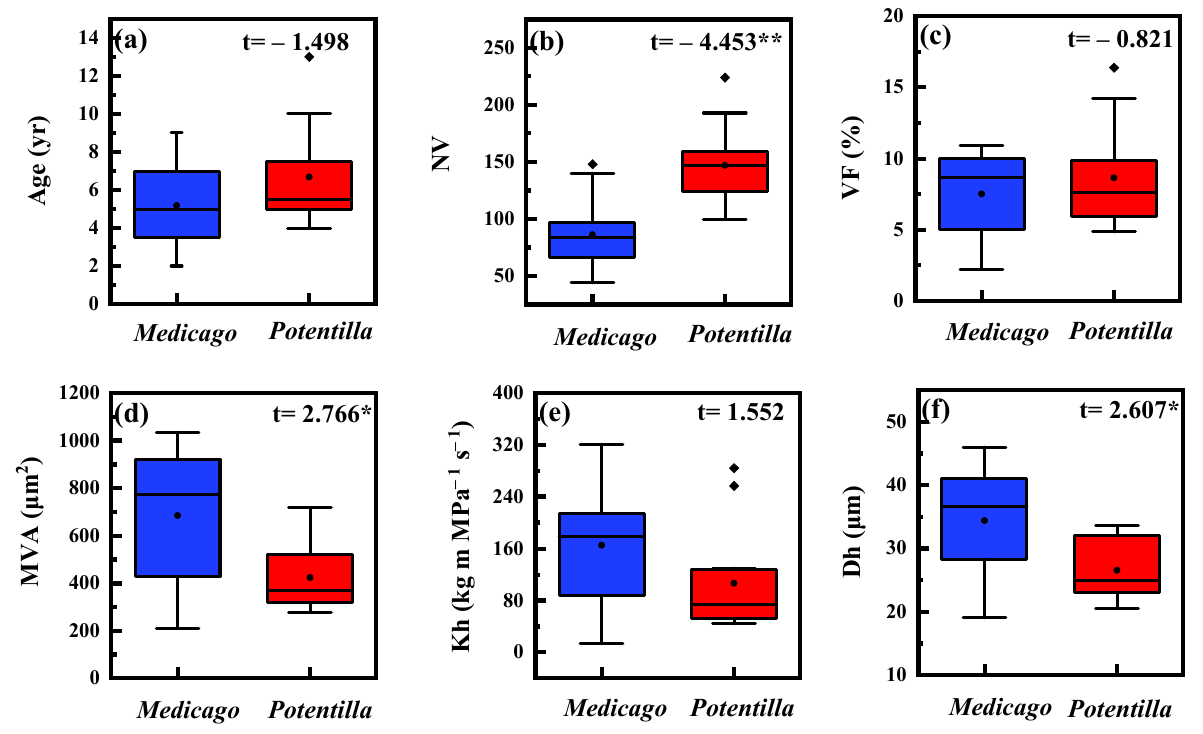
Figure 4. Boxplot of the major hydraulic traits in secondary root xylem of non-native and native forbs in arid and semiarid areas. ( a ) age; ( b ) vessel number (NV); ( c ) vessel fraction (VF); ( d ) mean vessel area (MVA); ( e ) the potential hydraulic conductivity (Kh); ( f ) hydraulic diameter (Dh). The blue and red boxes indicate Medicago and Potentilla herbaceous species, respectively. The t -test results between Medicago and Potentilla forbs are highlighted. * p < 0.05; ** p < 0.01.